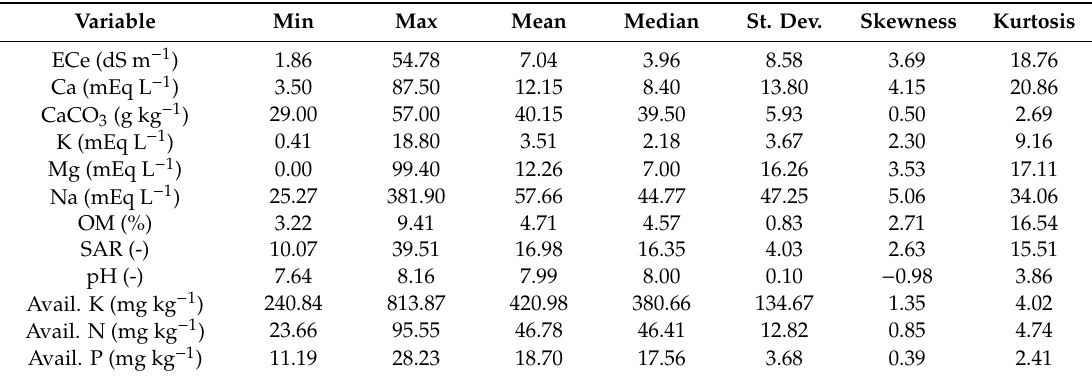
Table 1. Basic statistics of soil